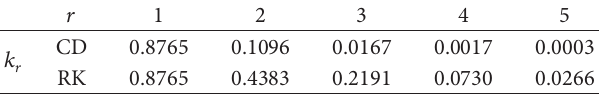
Table 2: Constants 𝑘 𝑟 concealing the temporal error with the CD and the RK time